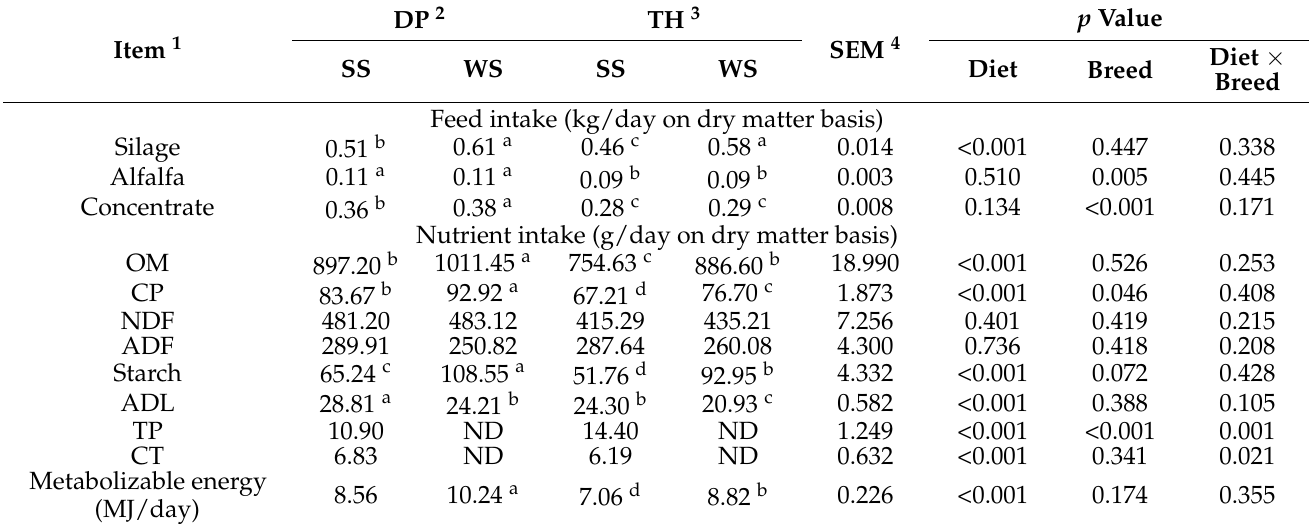
Table 2. Effect of silage diet and breed on nutrient intake of lambs ( n = 7 per group).